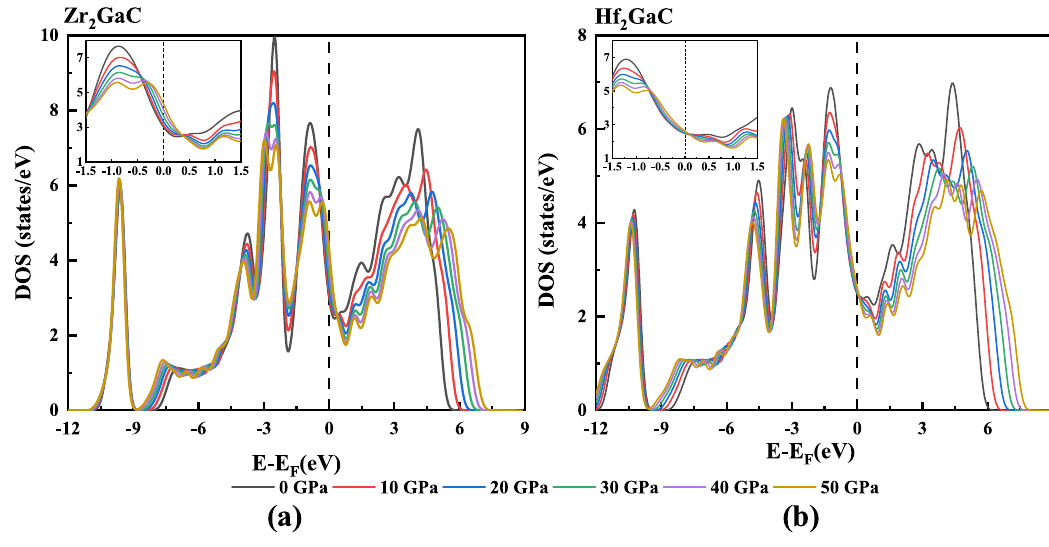
Figure 6. Total density of states (DOS) from GGA-PBE for M 2 GaC MAX phase (M = Zr, Hf) at different pressure. Figure inserted showing the effect of pressure in TDOS at Fermi level. Fermi level is set to 0 eV.